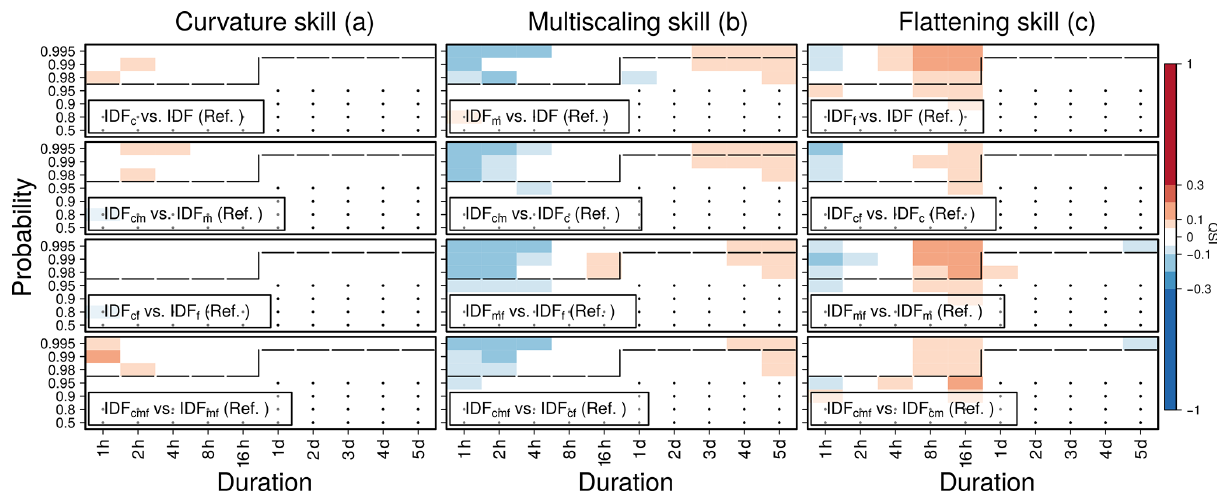
Figure 4. Quantile skill index for data with an hourly resolution. The visualization scheme follows that of Fig. 3. Here, all models were trained and tested for durations d ≥ 1. Here, all stations were considered, regardless of the temporal